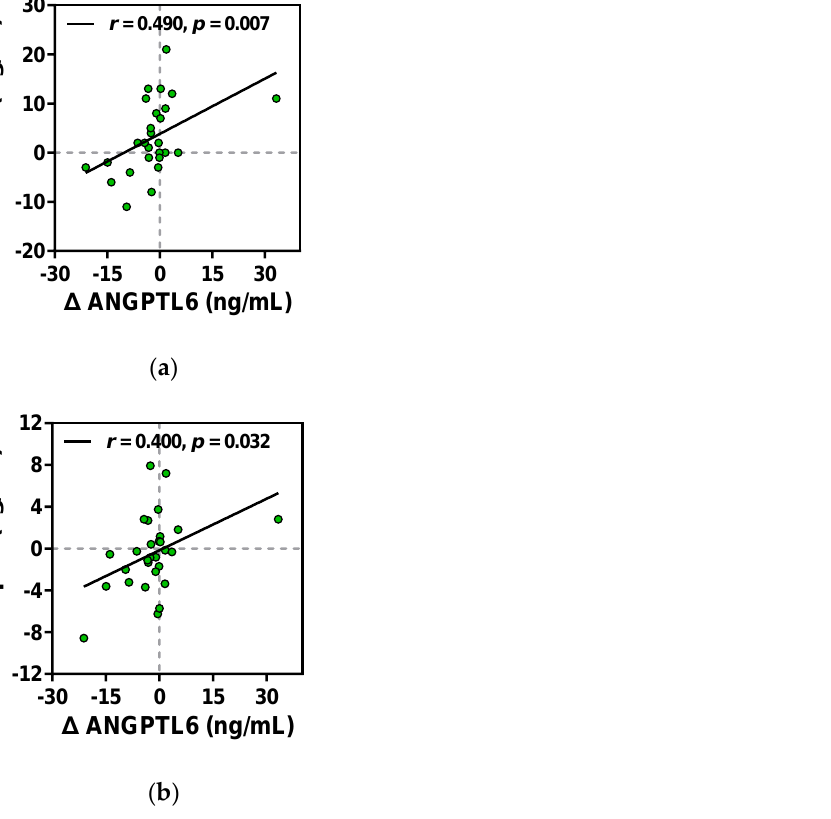
Figure 5. Correlations of Δ ANGPTL6 level with ( a ) Δ glucose and ( b ) Δ leptin levels before and after the intervention. Correlation coefficient (r), corresponding regression and 95% CI lines, and p -values are represented in the respective panels. Green-filled circles are individual values.